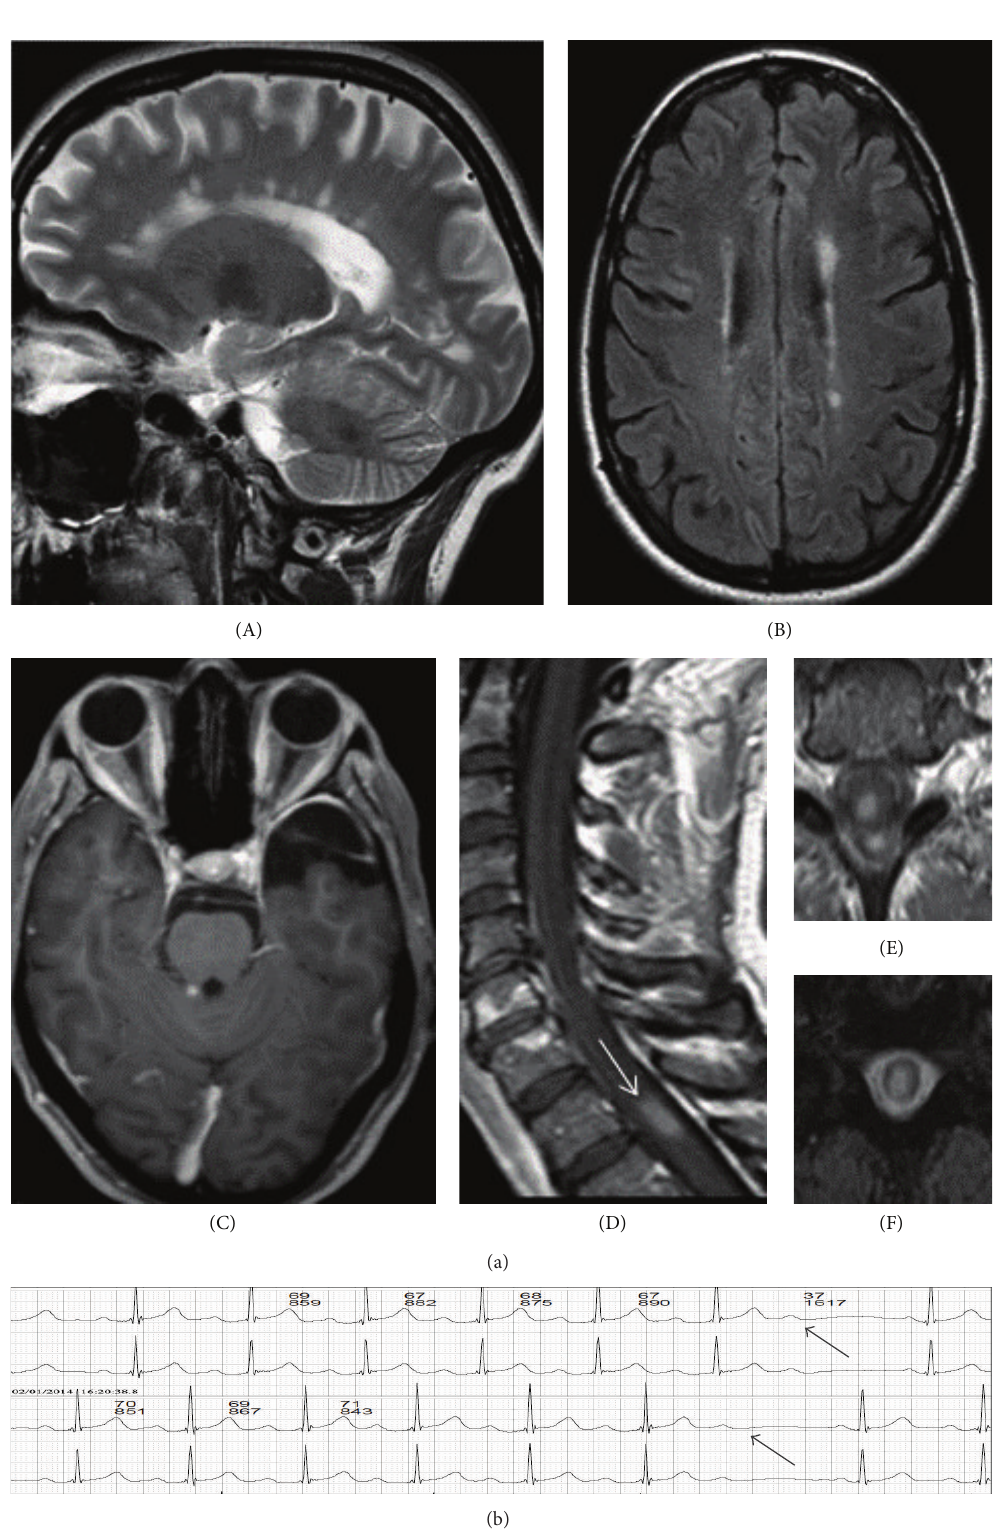
Figure 1: (a) Magnetic resonance imaging of the brain and spinal cord at relapse. (A) Sagittal T2-weighted image showing lesions in the corpus callosum. (B) Axial FLAIR image showing hyperintense lesions in the periventricular white matter of both hemispheres. (C) Axial T1- weighted image showing a gadolinium-enhancing lesion in the right upper and middle cerebellar peduncle. (D) Sagittal T1-weighted image showing a gadolinium-enhancing lesion on thoracic spinal cord at T1-T2 level. ((F) and (E)) Axial T2- and T1-weighted images of the spinal cord showing the extent of the T1-T2 lesion in the axial plane and that of gadolinium enhancement, respectively. (b) ECG Holter strip that shows Weckenbach type 2nd degree AV block 5 hours after initial dose of